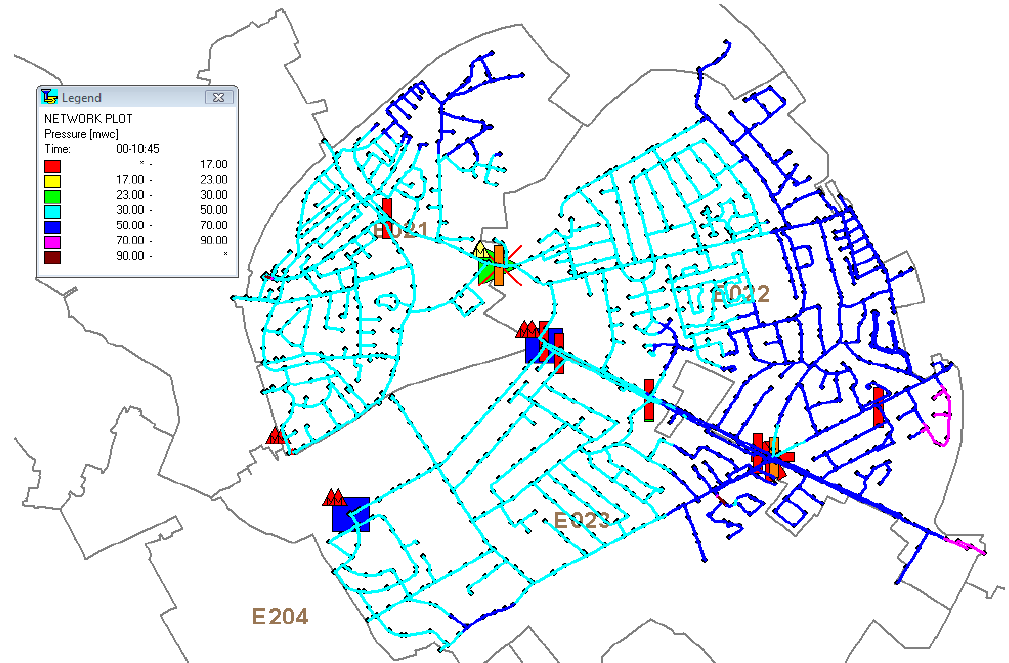
Figure 5. 3 DMA online model showing pressure in pipes at